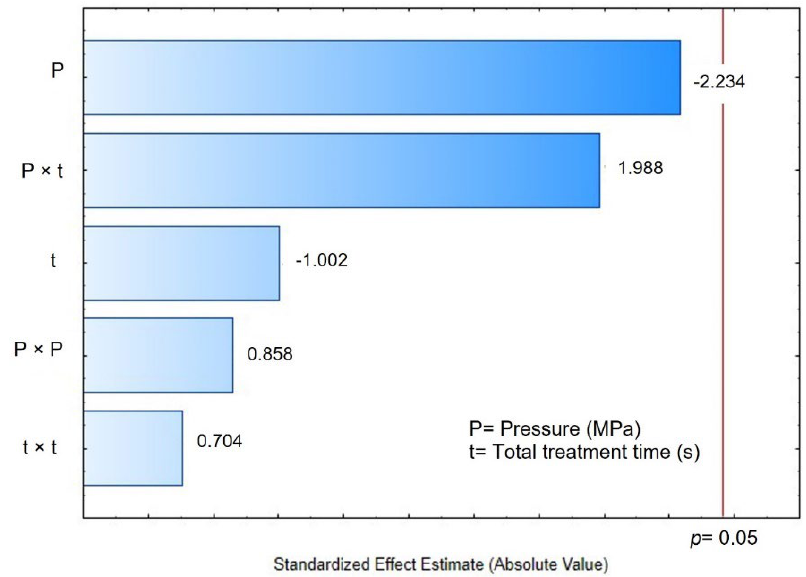
Figure 4. Pareto chart: the effects of steam pressure (MPa) and time (s) of DIC treatment on the apparent drying coefficient (10 − 10 m 2 /s) of maize kernels.